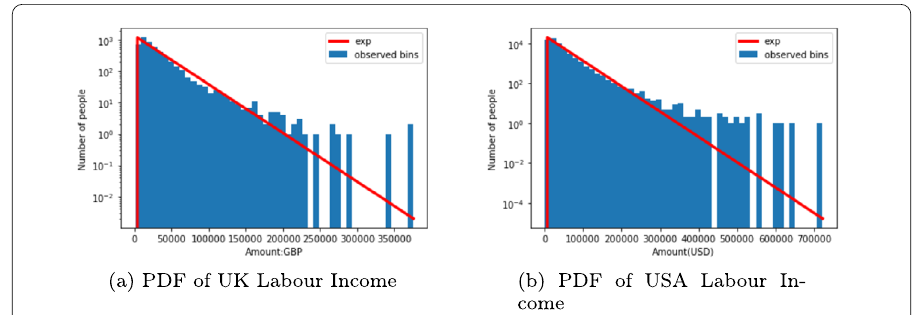
Figure 3 PDF Plots of the labour income bins of population and corresponding exponential distributions after 18 Simulated Waves, which confirms the exponential behaviour for low and mid-income